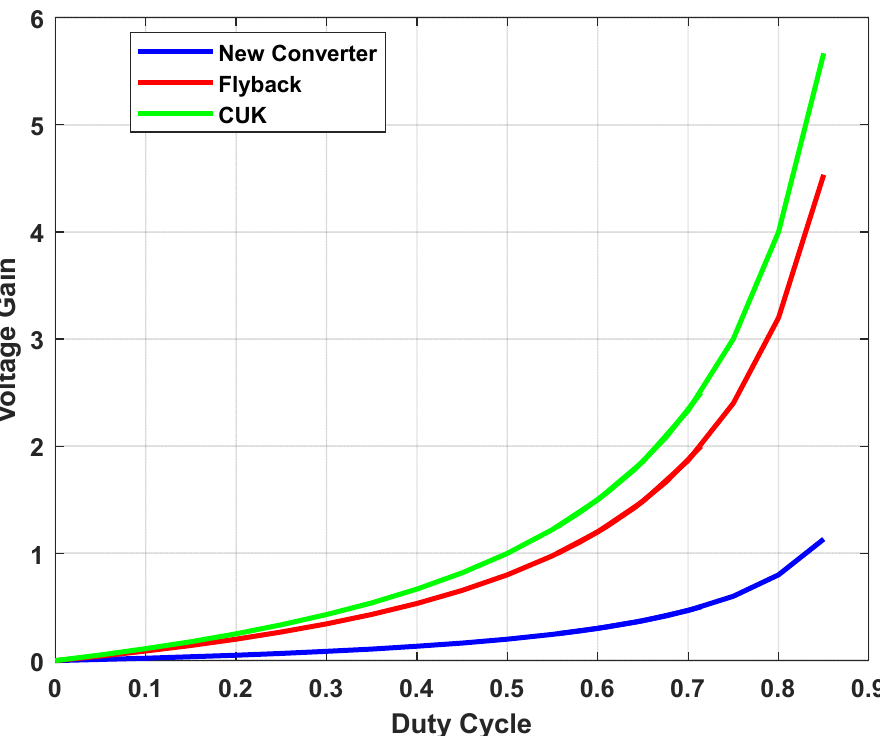
Figure 5. The voltage gains of three converters for different duty cycles.